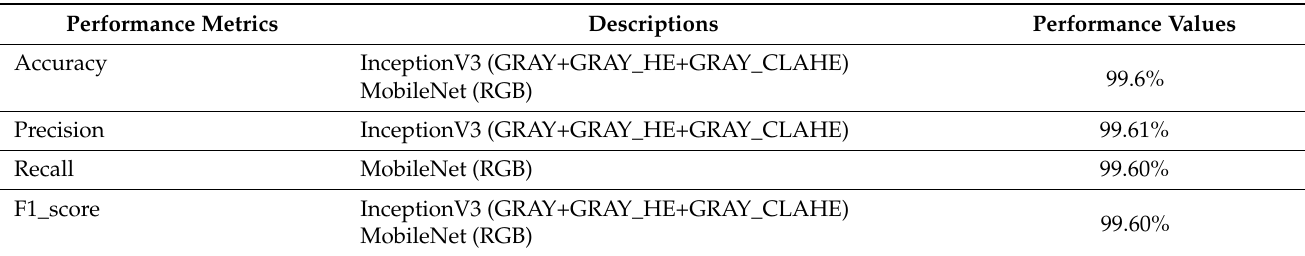
Table 7. Best-performed models for each performance metric.